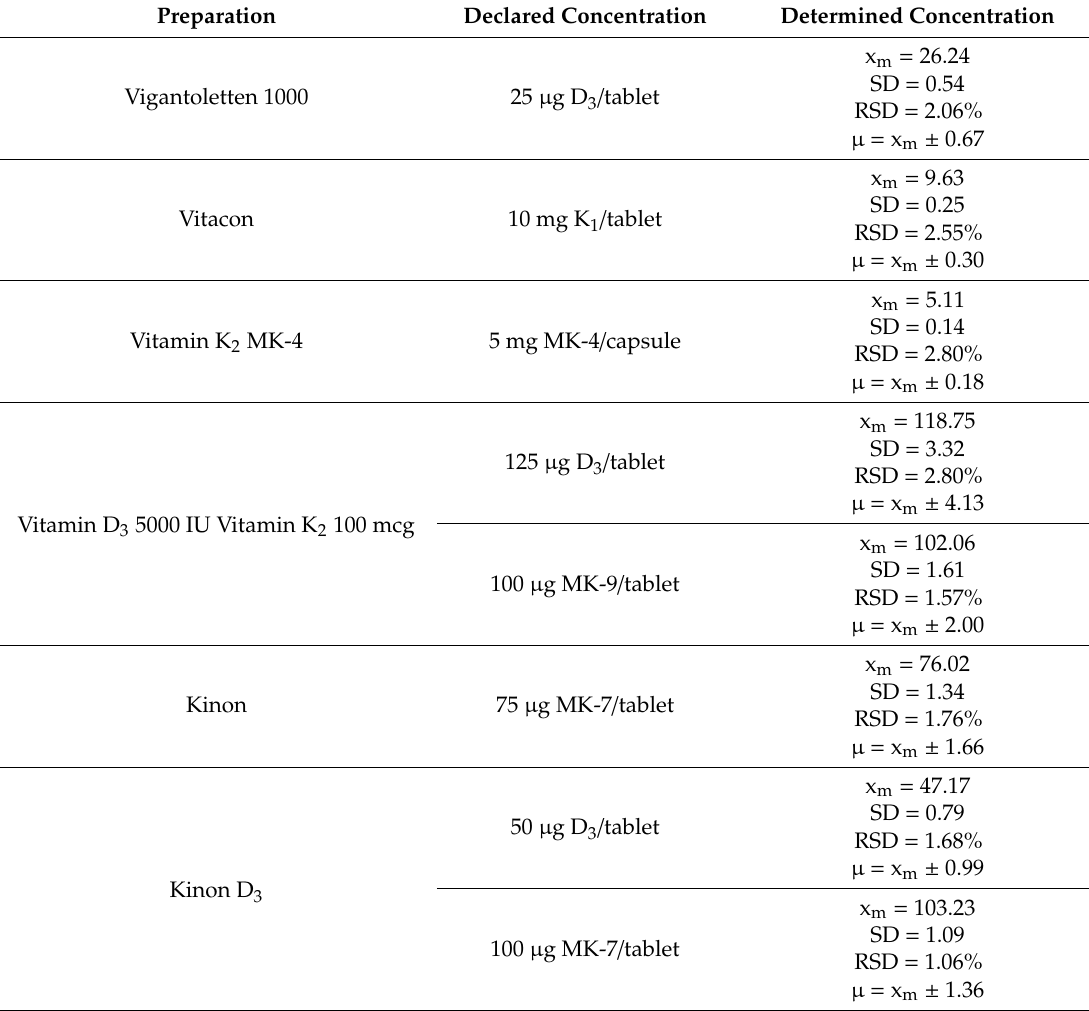
Table 3. Results of vitamins’ determination in pharmaceutical products and dietary supplements with statistical evaluation.